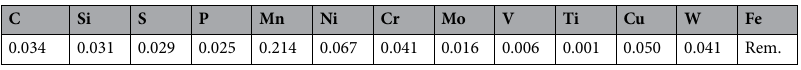
Table 1. Chemical composition of St14 steel